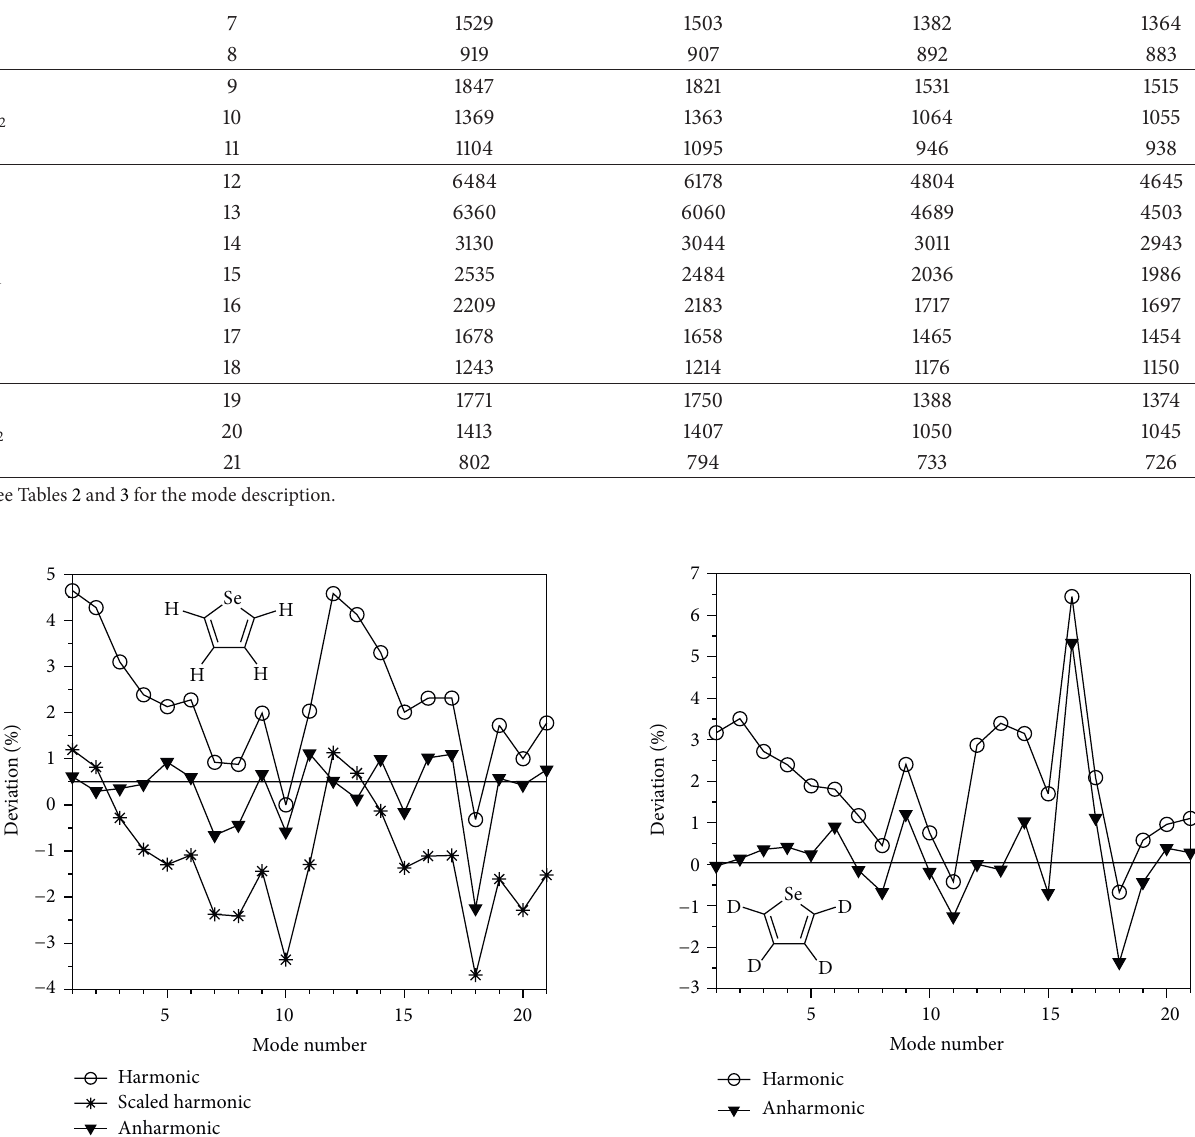
Figure 3: Percentage deviation relative to experiment [22, 23] of the B3LYP/6-311G ∗∗ wavenumbers of C 4 D 4